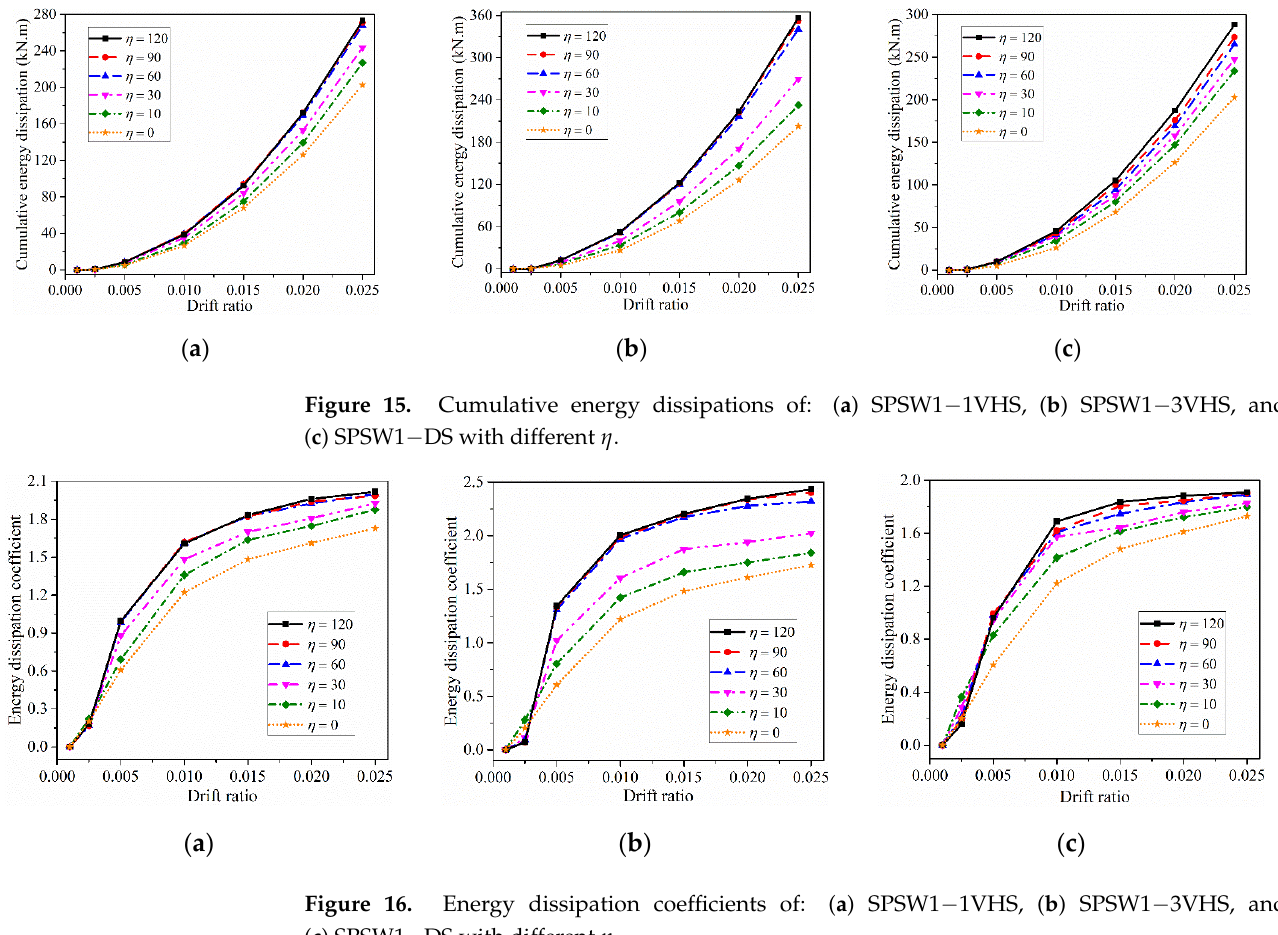
Figure 14. Secant stiffness reductions of: ( a ) SPSW1 − 1VHS, ( b ) SPSW1 − 3VHS, and ( c ) SPSW1 − DS with different η .